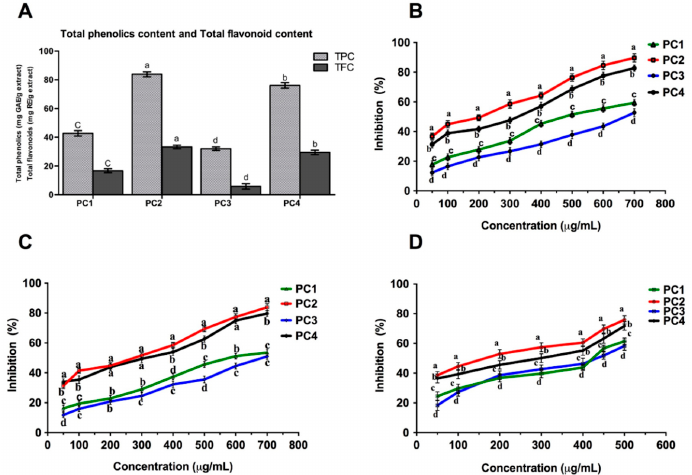
Figure 1. Total phenolics/ flavonoids and antixoidants activities of extracts of four persimmon cultivars. ( A ) Total phenolics and flavonoids content; ( B ) DPPH radical scavenging activity; ( C ) ABTS radical scavenging activity and ( D ) Superoxide radical scavenging activity of different persimmon cultivars seeds. Values in the different lower-case letters are significantly different at p < 0.05, ( n = 3). The phenolic contents in the seeds of the persimmon cultivars were in the following order: PC2 > PC4 > PC1 > PC3. Cultivar PC2 had a significantly ( p < 0.05) higher TPC, exhibiting